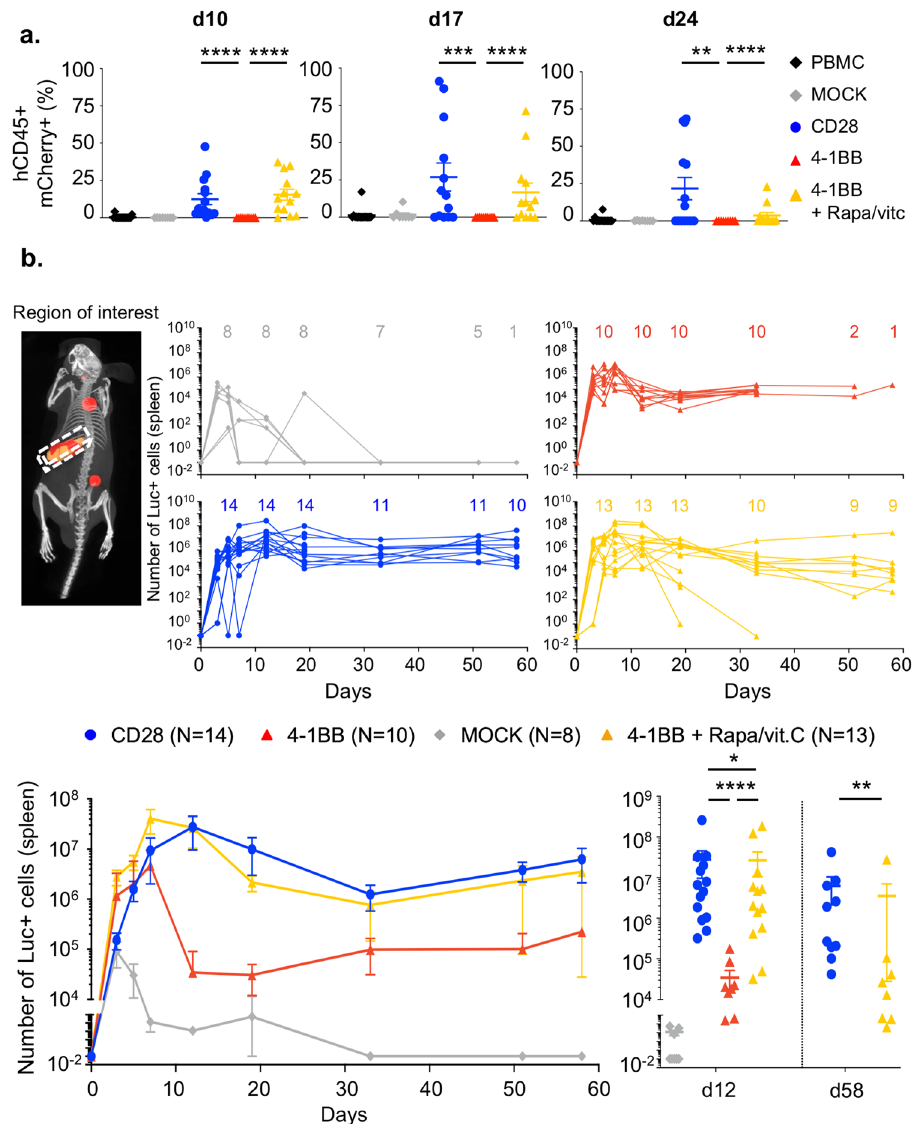
Fig. 7 4-1BB tonic signaling limits the in vivo expansion and persistence of CAR-Tregs. Panels a and b show results over three independent experiments and from three different donors, except for the groups MOCK-Tregs (two experiments) and 4-1BB CAR-Tregs (one experiment). a Frequencies of CAR- expressing (mCherry + ) cells among the total circulating cells assessed by fl ow cytometry. Statistical signi fi cance is observed in the following comparisons: CD28 ( n = 14) vs. 4-1BB ( n = 10), p < 0,0001 (day 10), p = 0,0010 (day 17), p = 0,0044 (day 24); and 4-1BB vs. 4-1BB + rapamycin/vitamin C ( n = 13), p < 0,0001 (day 10), p < 0,0001 (day 17), p < 0,0001 (day 24). PBMCs only n = 16, MOCK-Tregs n = 8. b 3D bioluminescence imaging tomography (DLIT) of recipient mice was performed as described in the Methods. A region of interest (ROI) corresponding to the spleen was determined by coregistration with the Automatic Mouse Atlas (upper left panel), and the absolute number of luciferase-positive (Luc + ) cells was calculated. Individual kinetics of the absolute number of Luc + cells for each mouse corresponding to each group and the number of living animals per timepoint are shown (upper panels). Grouped kinetics are shown in lower left panel. The number of mCherry-positive cells was measured in each group at day 12 (CD28 CAR-Tregs, n = 14; 4-1BB CAR-Tregs, n = 10; 4-1BB CAR-Tregs + rapamycin/vitamin C, n = 13; and MOCK-Tregs, n = 8 living animals) and day 58 (CD28 CAR-Tregs, n = 10; 4-1BB CAR-Tregs + rapamycin/vitamin C, n = 8 living animals) (lower right panel). Statistical signi fi cance is observed in the following comparisons: CD28 vs. 4-1BB, p < 0.0001 (day 12); MOCK vs. 4-1BB, p = 0.0238 (day 12); 4-1BB vs. 4-1BB + Rapa/vitC, p < 0.0001 (day 12); and CD28 vs.